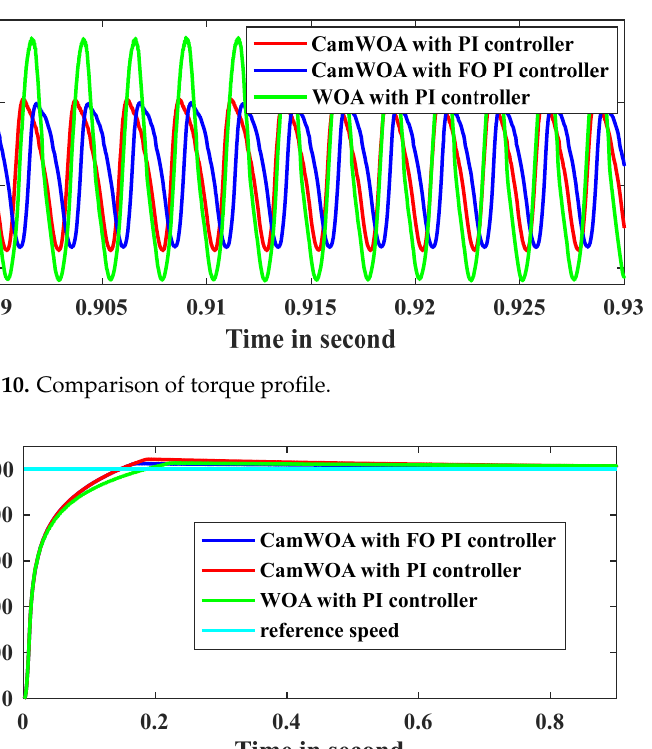
Figure 9. Stator 4-phase current with time in second of SRM drive using PI controller and WOA algorithm.